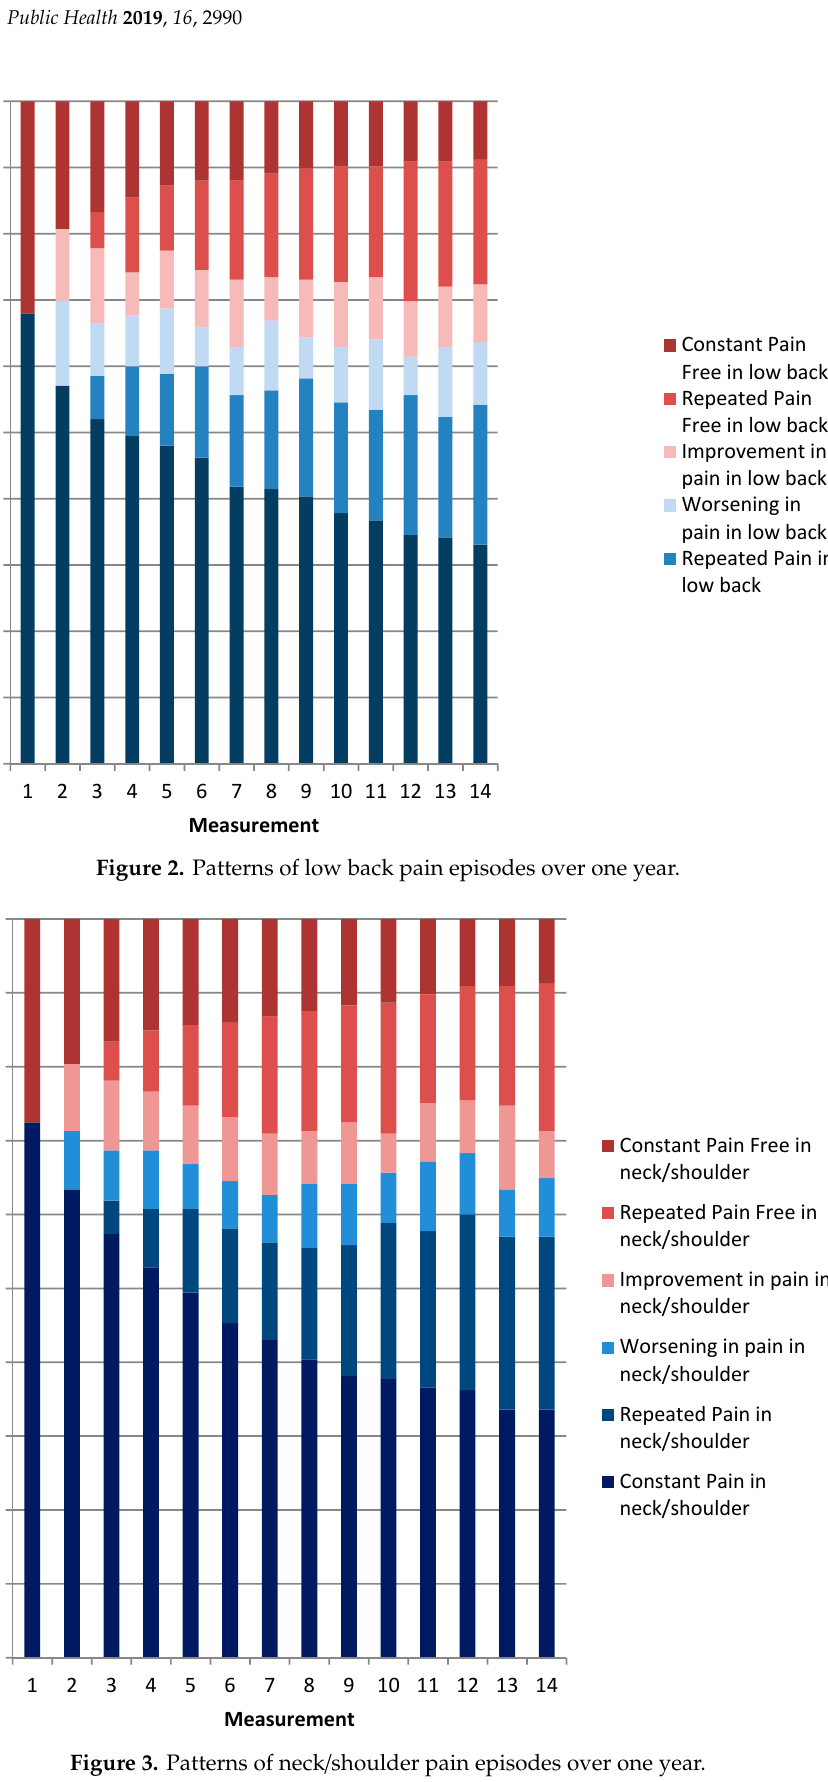
Figure 3. Patterns of neck / shoulder pain episodes over one year.